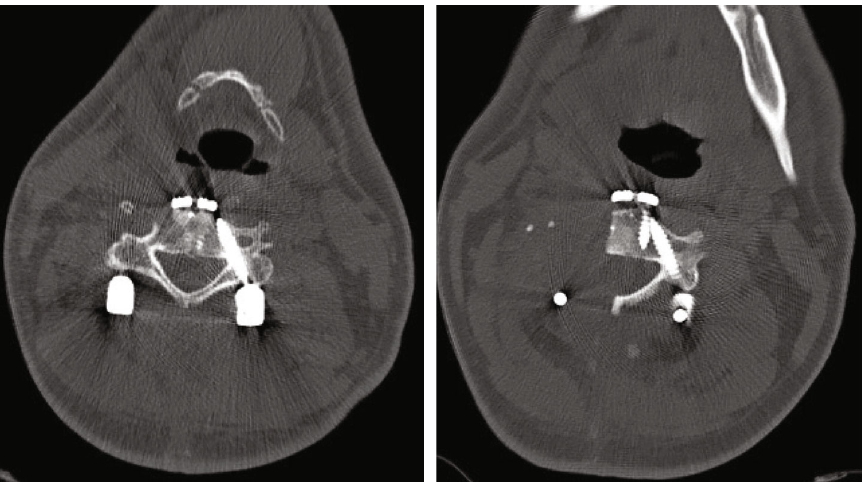
Figure 4: Precision of screw positioning. Axial reconstructions of the postoperative CT scan (case 2) to evaluate the correct placement of the pedicle screws. In both examples, the correct position of the screws could be con fi rmed.